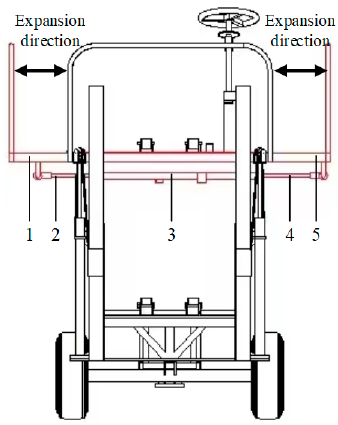
Figure 2. Structural diagram of the high-level expendable working platform. 1 and 5 represent the expansion pedals, 2 and 4 represent the hydraulic cylinders, and 3 represents the sliding rails.